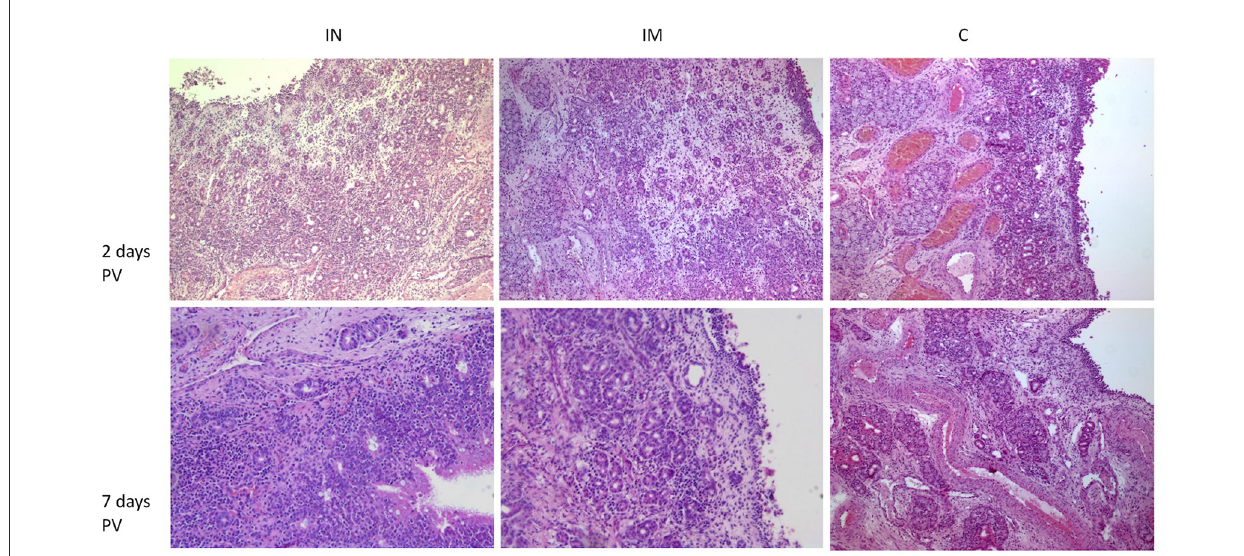
FIGURE5 Histological features of nasal mucosa sections in the IN-vaccinated group, IM-vaccinated group and C group at 2 days and 7 days PV. H&E (100 × magnification). IN group: at 2 days PV, epithelium, superficial and deep corium are diffusely infiltrated by lymphocytes, plasma cells and macrophages with superficial edema; at 7 days PV, within superficial corium, a diffuse and dense inflammatory infiltrate composed predominantly by numerous lymphocytes and plasma cells is present. Numerous intraepithelial lymphocytes are visible within epithelium. IM group: at 2 days PV, deep corium is multifocally infiltrated mainly by lymphocytes and plasma cells, while superficial corium is edematous; at 7 days PV, within superficial corium, a periglandular lymphoplasmacytic infiltrate is present; the epithelium is focally eroded. C group: at 2 days PV, within superficial corium, a multifocal lymphoplasmacytic infiltrate is present; at 7 days PV within superficial corium, a low number of lymphocytes and plasma cells surround glands and capillaries. IN, intranasally; IM, intramuscularly; C, control; PV, post-vaccination; H&E, hematoxylin and